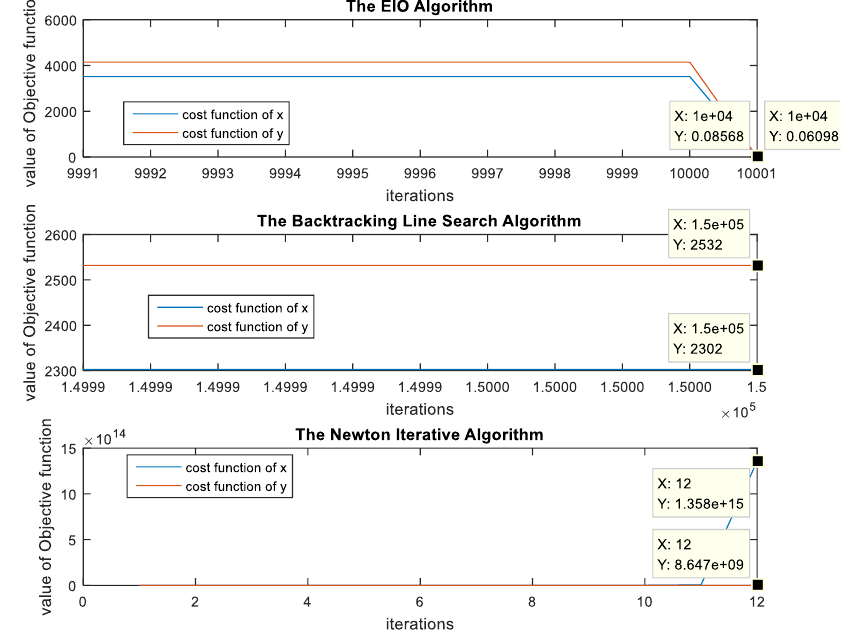
Figure 2. The comparison among the optimized objective function curves of the EIO algorithm, the individual Newton method, and the backtracking line search gradient decent method.